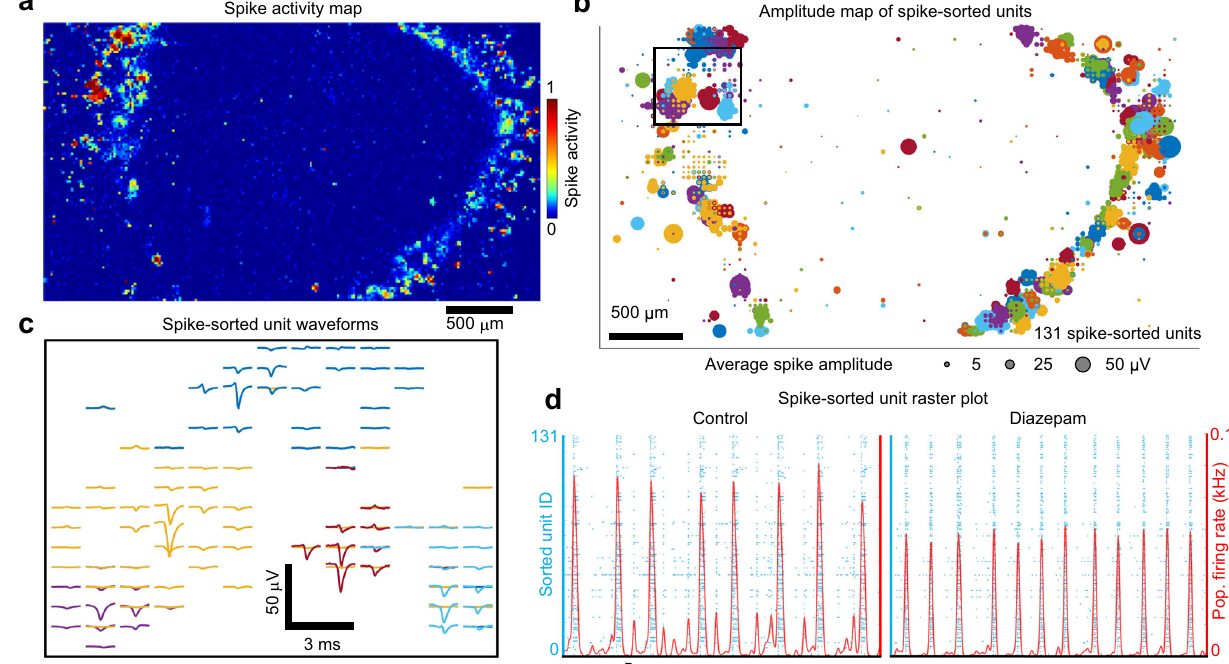
Fig. 1 | High-resolutionmaps ofextracellularaction potentials across a human brain organoid slice. a Spatial map of extracellular action potential activity recorded from a 500 µ m thick human brain organoid slice positioned on a high- density CMOS microelectrode array with 26,400 recording electrodes to survey electrical activity across the entire organoid. The color scale indicates the nor- malized number of detected spikes (above 5x-rms noise) registered at each elec- trode site measured over a 30s interval. Scale bar 500 µ m. b Spatial map of the mean extracellular action potential spike amplitude (bubble size) from single-unit activity measured simultaneously across the CMOS array from the top 1020 elec- trode sites based on activity. A total of 131 spike-sorted units were determined by